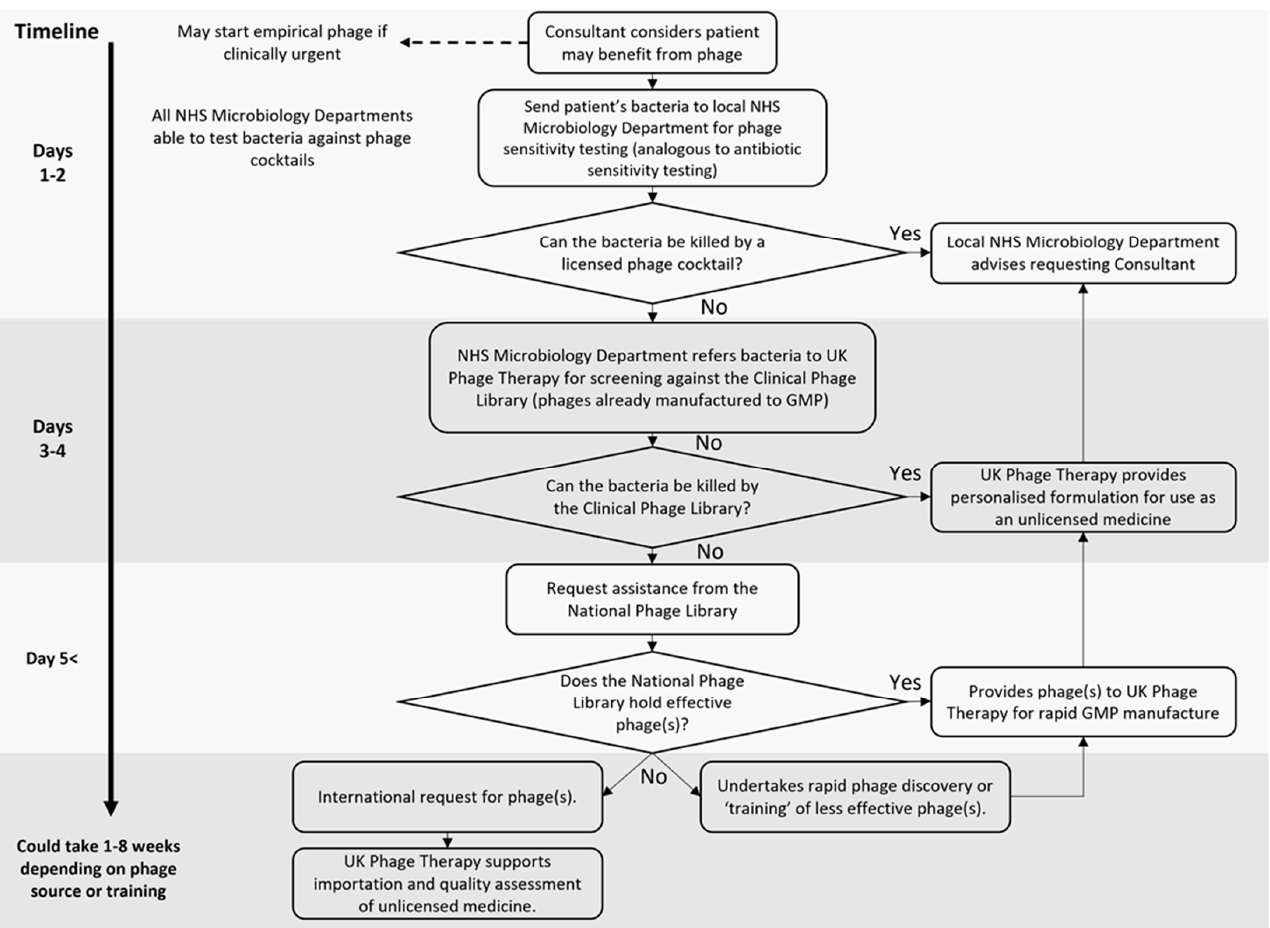
Figure 1. Future delivery of phage therapy by NHS microbiology services, UK Phage Therapy, and a National Phage Library.